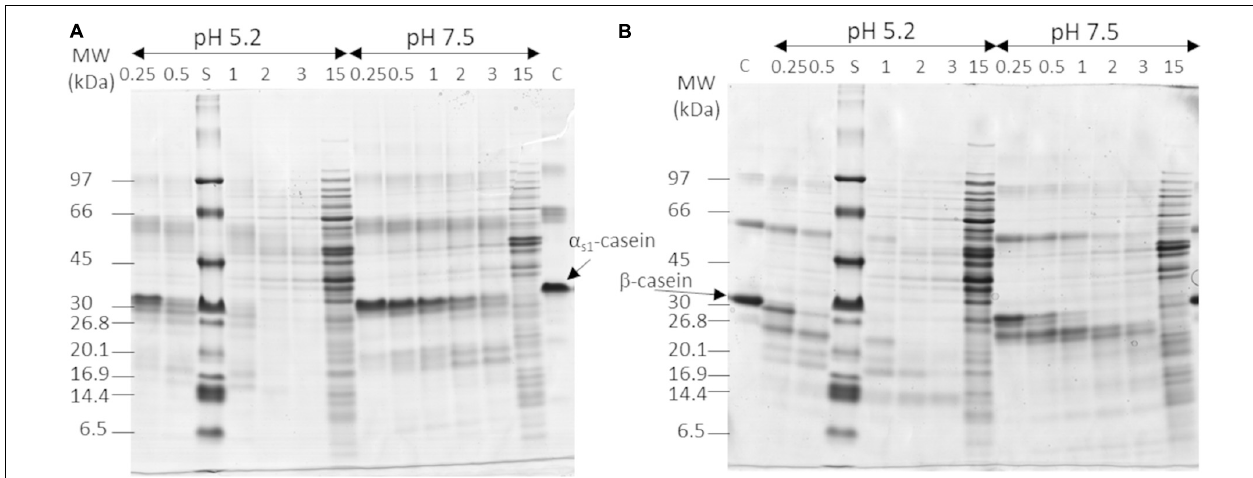
FIGURE 1 | In vitro hydrolysis of (A) α s1 -casein and (B) β -casein by Lactobacillus helveticus CIRM-BIA103 observed in Tris-tricine SDS-PAGE using 12–18% acrylamide gradient at NaCl 1.5% NaCl/moisture. Hydrolyzes were performed at pH 5.2 and 7.5 and samples were collected at six time points: 0.25, 0.5, 1 h, 2 h, 3 h, and 15 h. Molecular weight (MW) range of apparent molecular mass separation from 97 to 6.5 kDa are shown on the left side of each gel. Controls (C) are (A) α s1 -casein in pH 7.5 Tris-buffer and (B) β -casein in pH 5.2 lactate